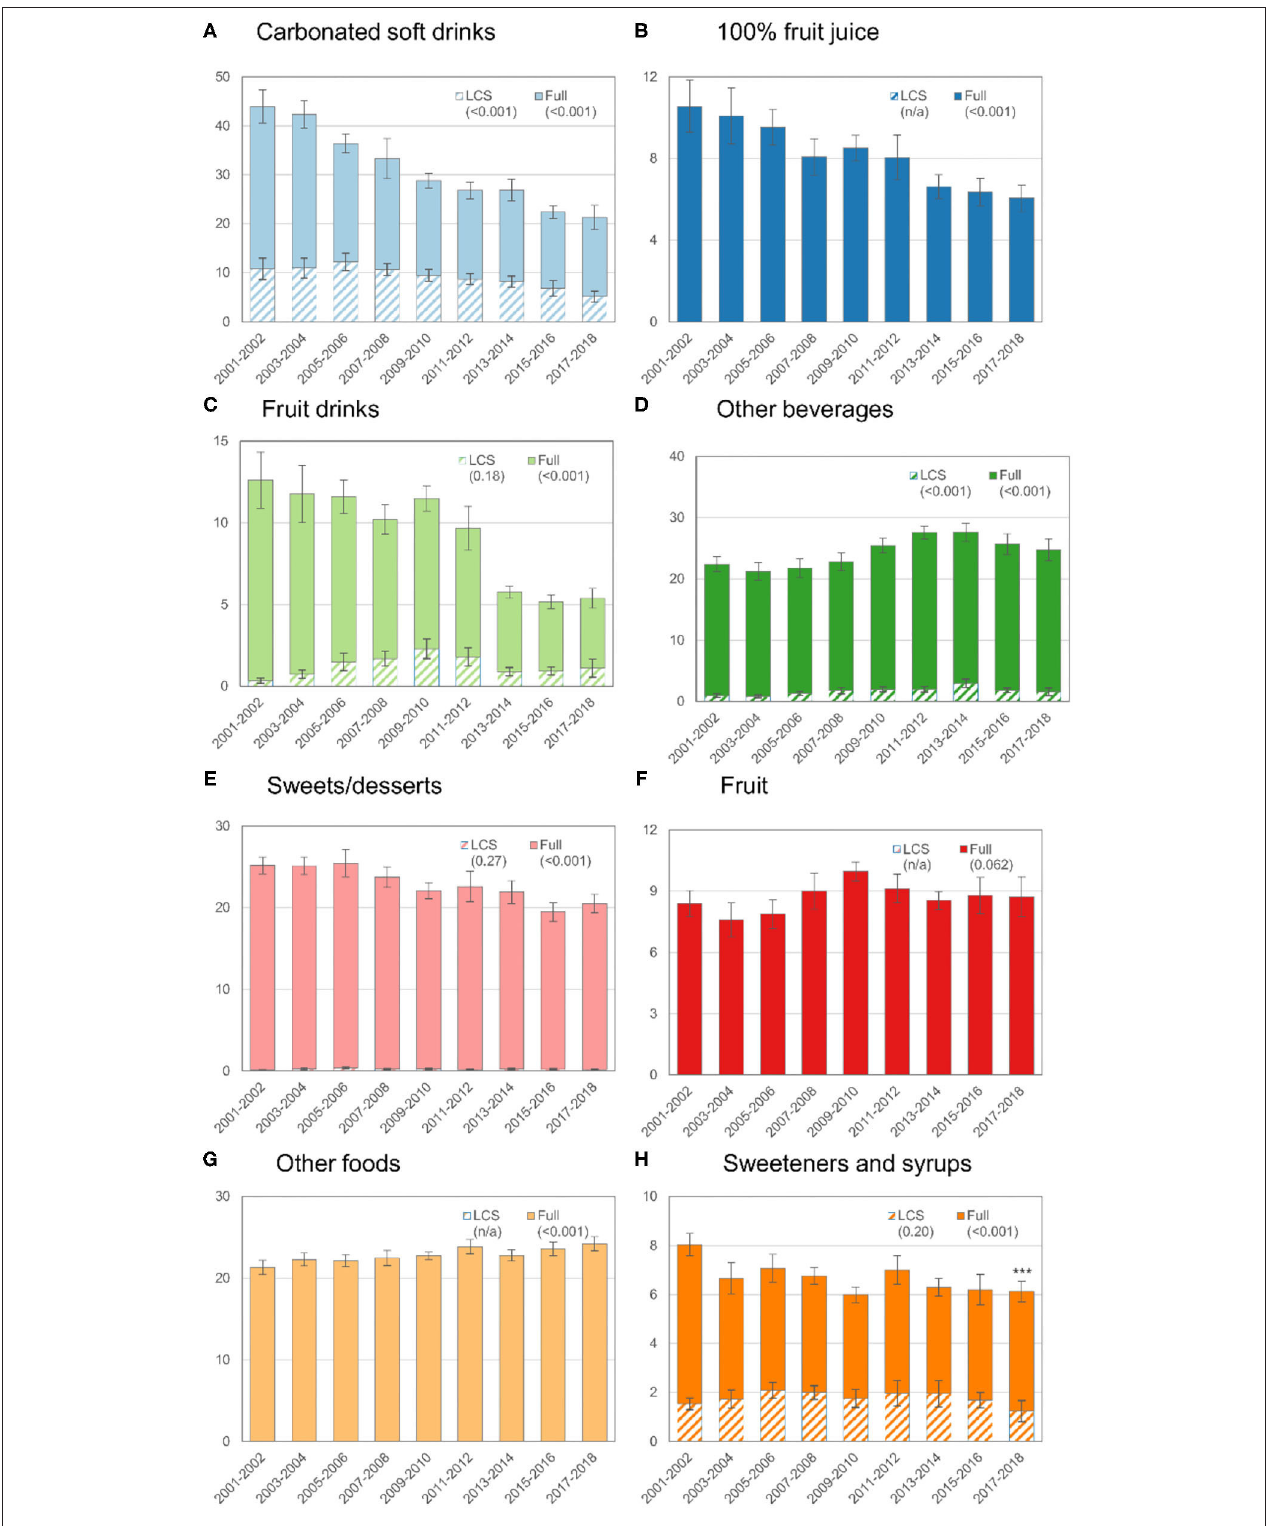
FIGURE 1 | Trends in mean ASEs by food or beverage category in the total population (age ≥ 2 y), 2001–2018. The y-axis for each graph is the ASE value and the hashed bars indicate the ASE from LCS sources (e.g., diet soft drinks, dietetic cookies, or tabletop sweeteners). The solid bars correspond to the total sugar from that source (e.g., full). The error bars correspond to the 95% confidence interval for the corresponding bar. The values in parentheses are the p -value for trend. The p -value for the trend was not estimated when the contribution of LCS sources to the ASE was 0 or very low (e.g., for fruit, 100% fruit juice, and other foods).